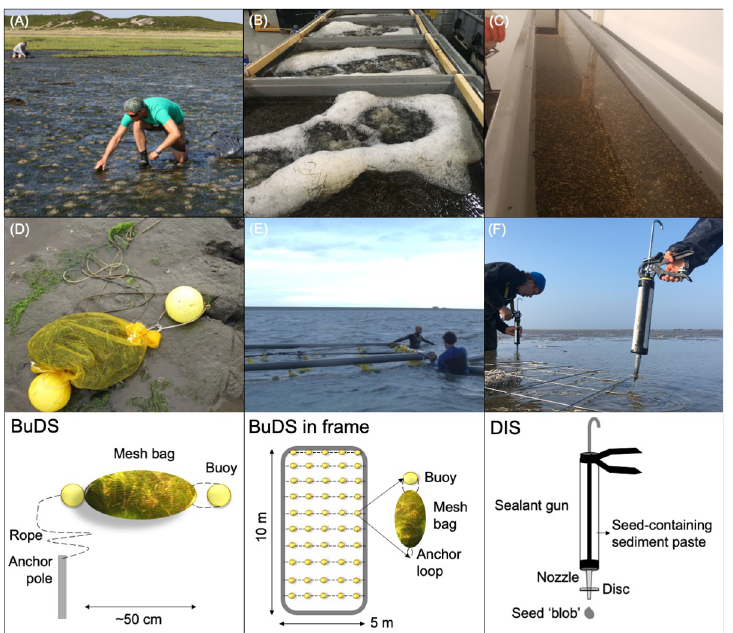
Fig 3. Visual overview of methods. (A) volunteer is selectively harvesting seed-bearing eelgrass shoots from the donor site on Sylt, (B) Harvested seed-bearing shoots are kept in aerated seawater tubs until all the seeds have dropped out of the spathes, (C) seeds are stored under controlled conditions with flow-through system, (D) Buoy Deployed Seeding (BuDS) in the intertidal, harvested material is put in a mesh bag (photo, illustration), (E) Buoy Deployed Seeding in frame (BuDS-in-frame) in the field (photo) and birdeye view (illustration), (F) Dispenser Injection Seeding (DIS) on the intertidal mudflats in spring (photo, illustration).